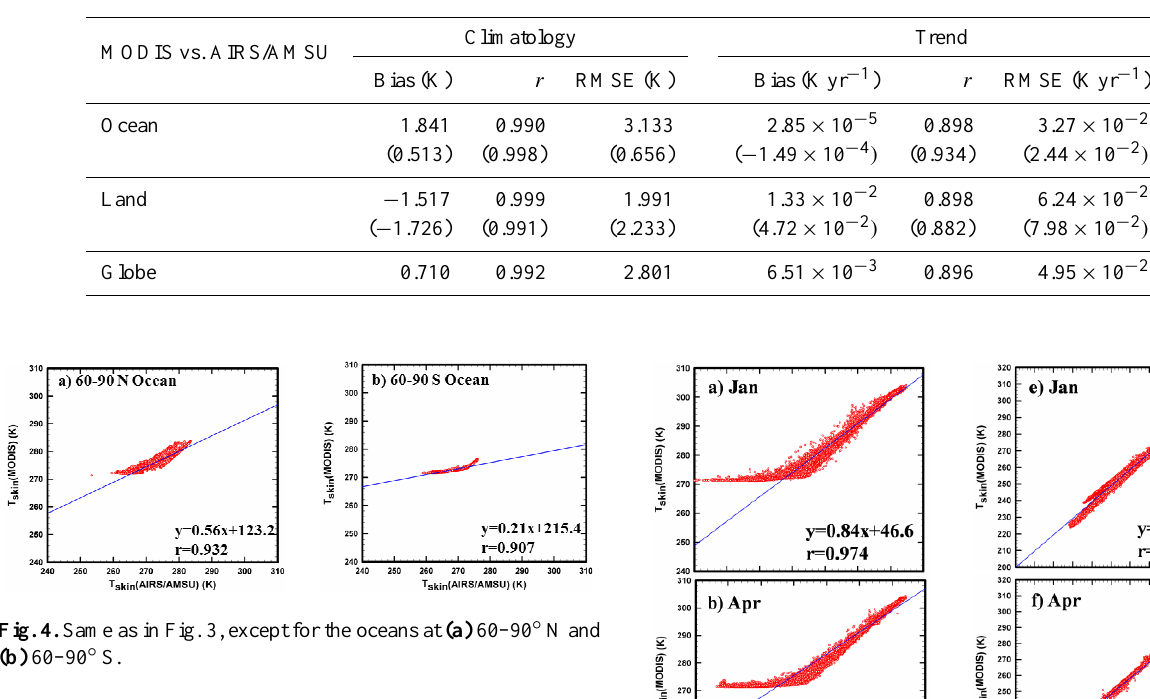
Table 2. Comparison of MODIS vs. AIRS/AMSU surface skin temperatures for their climatological annual average and monthly anomaly trends over the regions of ocean, land, and globe, respectively. Bias: MODIS minus AIRS/AMSU, r : correlation coefficient, RMSE: root mean square error. The values in parentheses indicate 50 ◦ N–50 ◦ S regions of the ocean and the land, respectively.